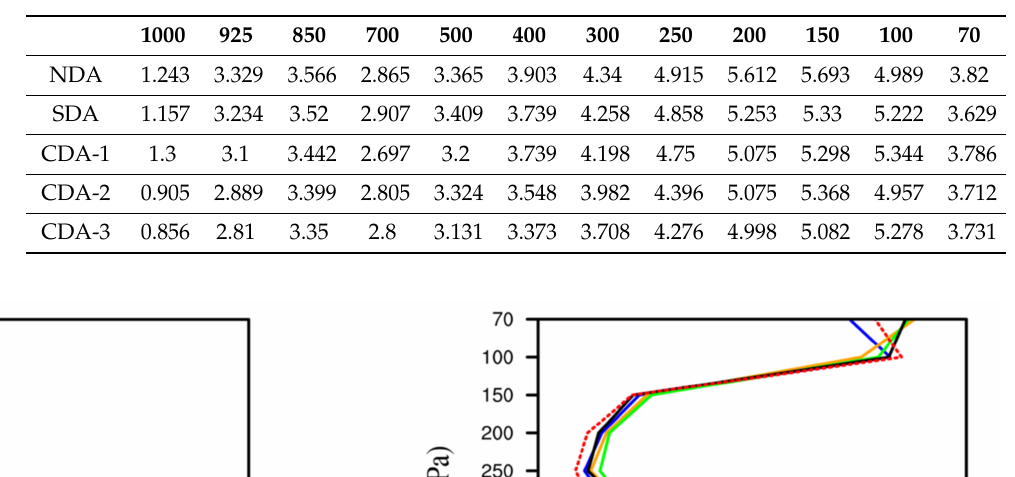
Table 5. The zonal wind RMSE (m/s) of 24 h forecasts verified against ERA-5 data at different levels (hPa).